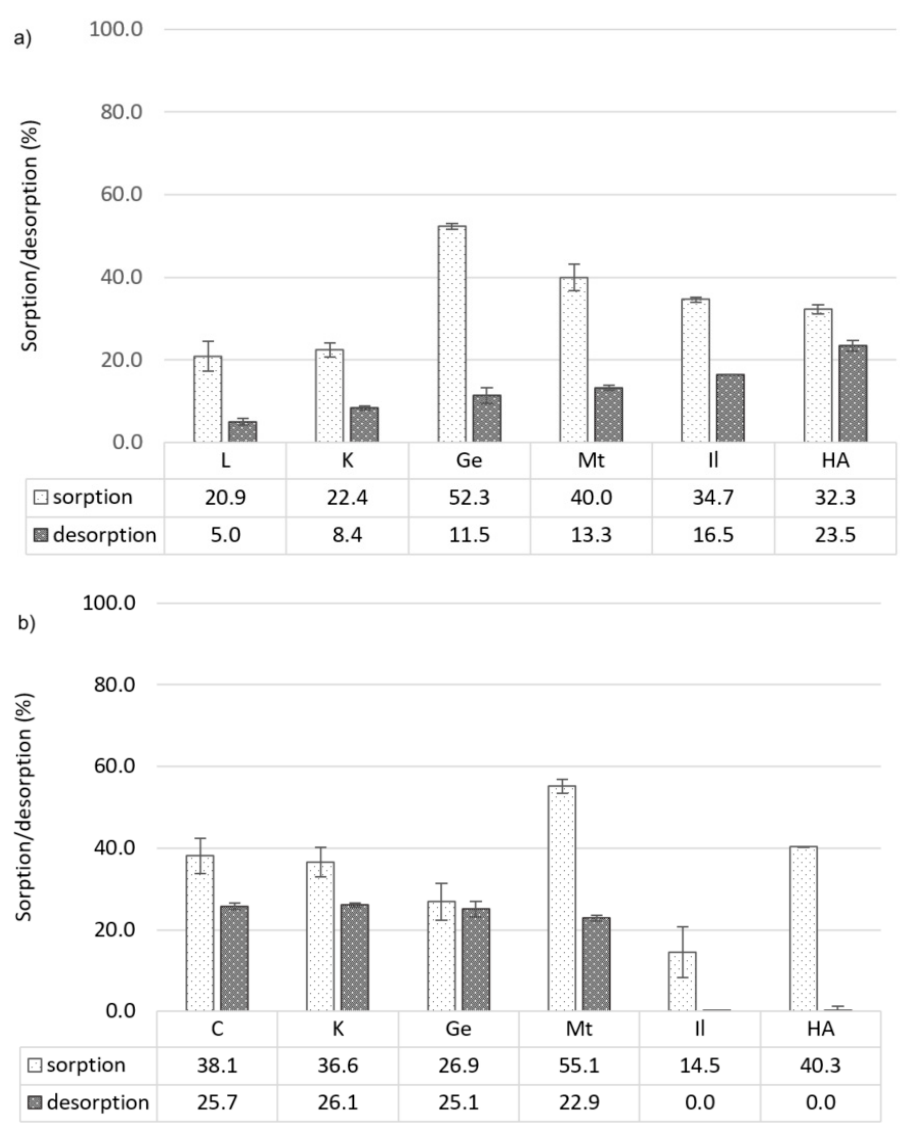
Figure 5. Comparison of sorption and desorption magnitude for carbofuran in ( a ) soil L and ( b ) soil C. Error bars represent standard deviation of triplicate samples.